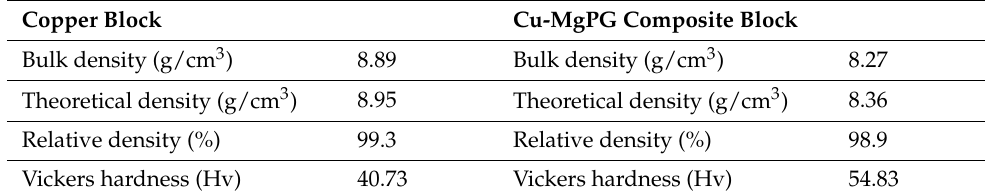
Table 1. Physical properties of the copper and the sintered composite blocks. Copper